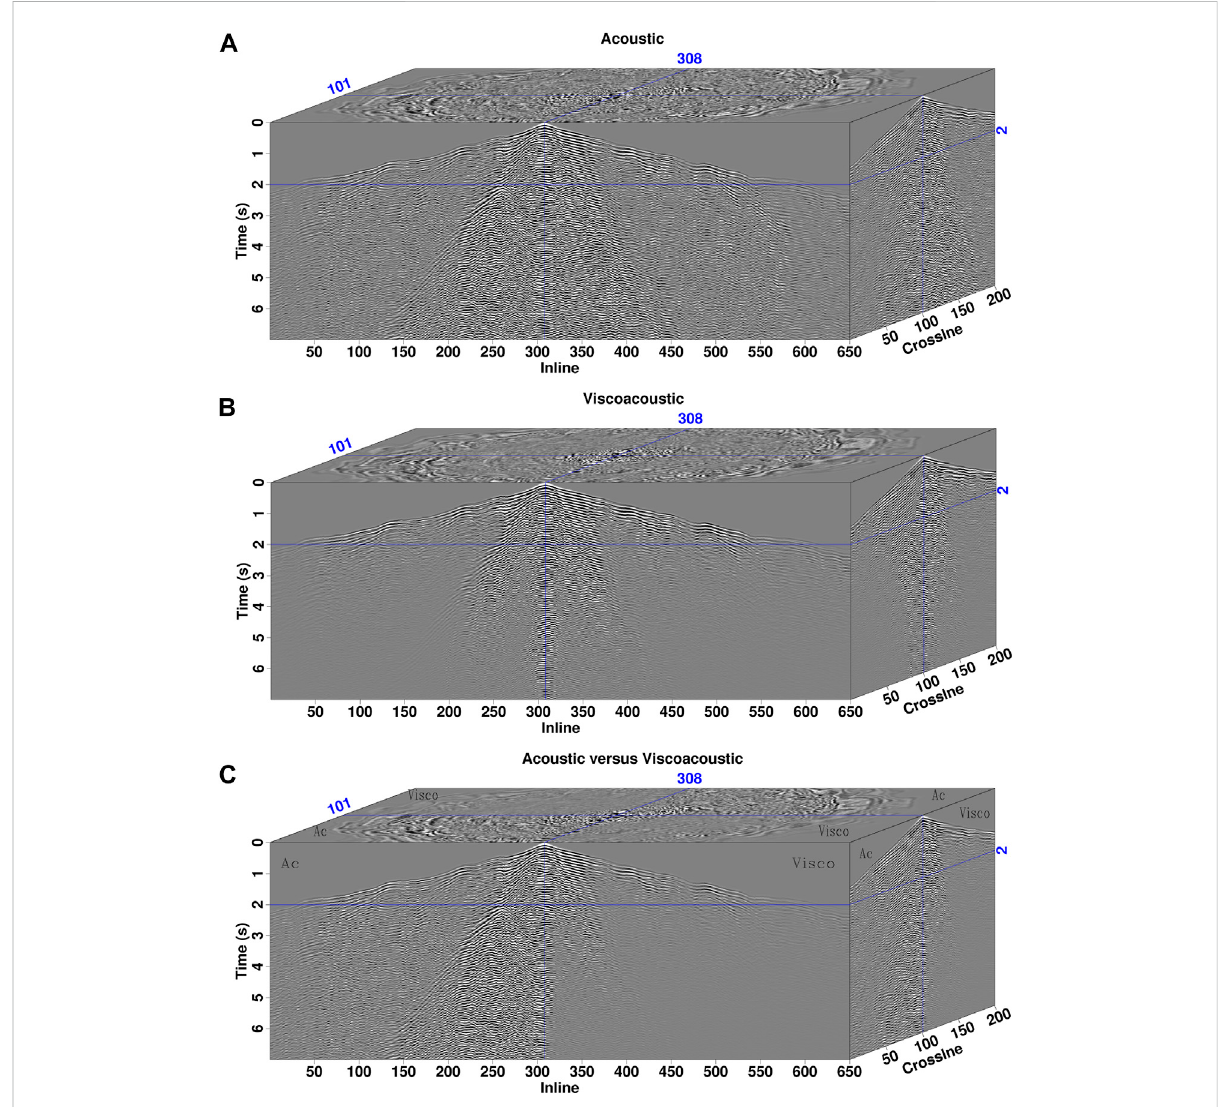
FIGURE 18 Common-shot gathers of 3D Loess Plateau model with the source location at the ditch. (A) Acoustic modeling result, (B) viscoacoustic modeling result, and (C) comparison of acoustic (Ac) versus viscoacoustic (Visco) modeling